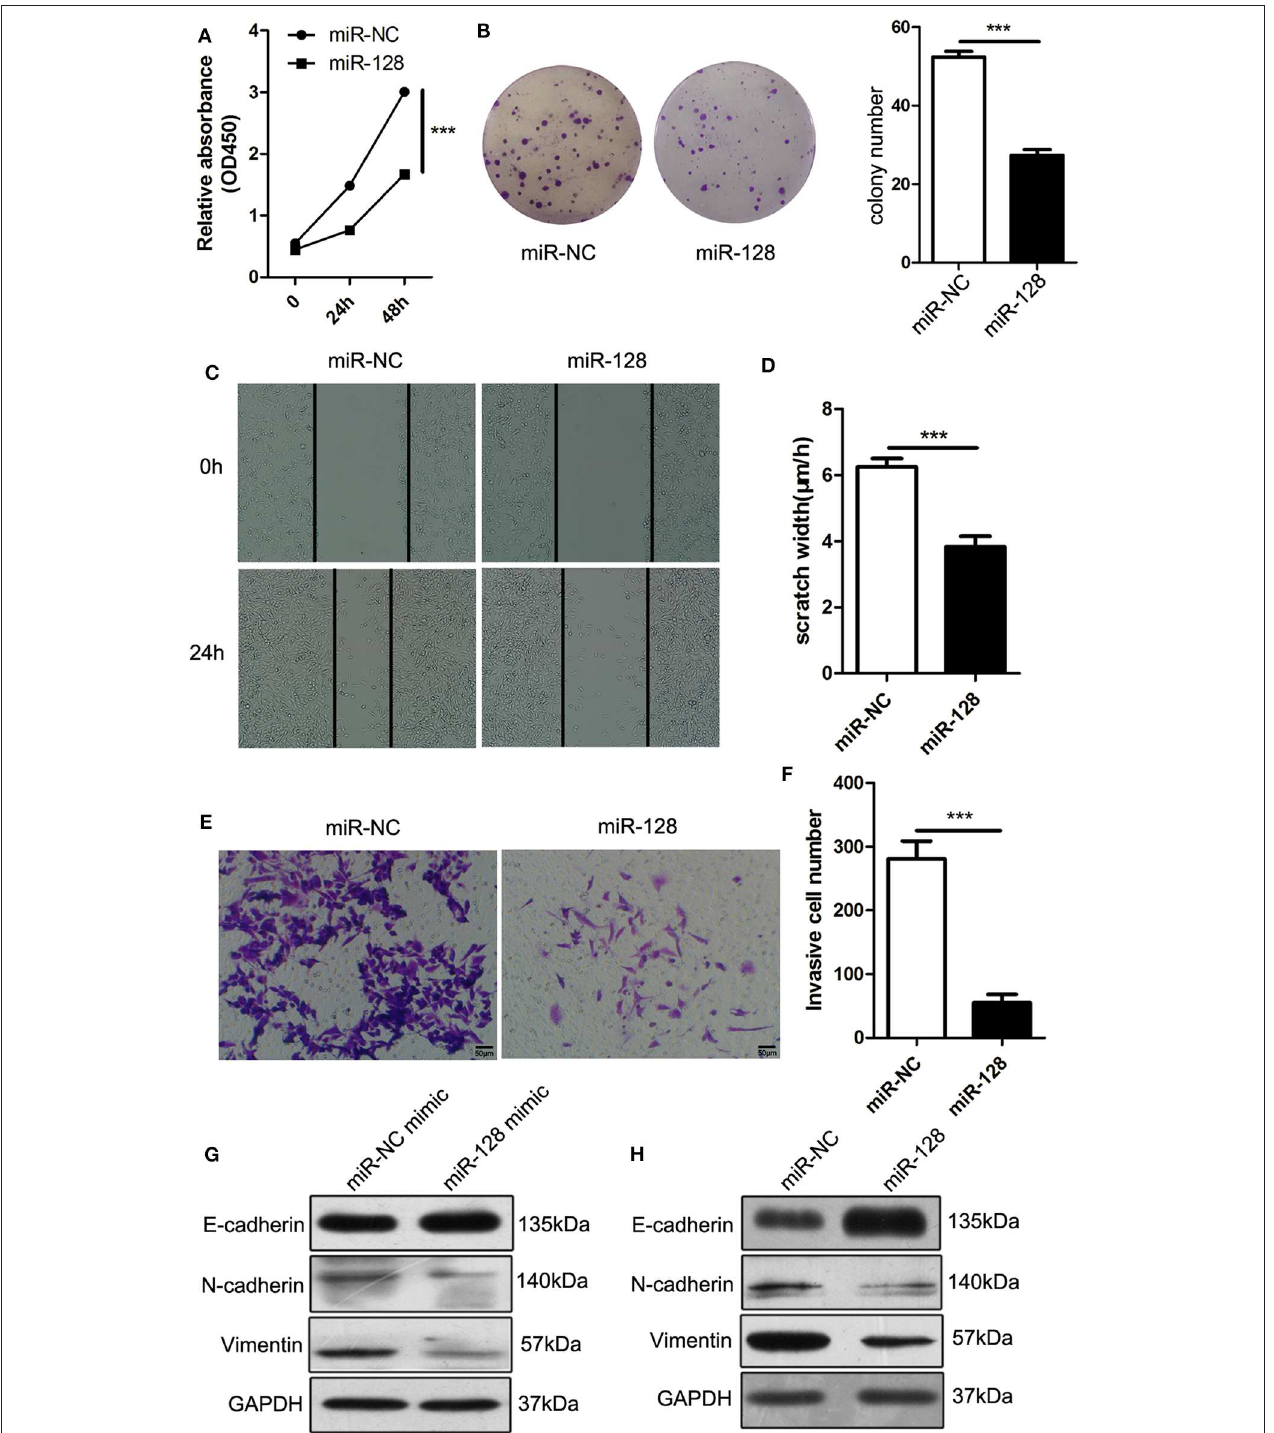
FIGURE 5 | MiR-128 inhibited the cell proliferation, migration, and invasion of PDAC cells. (A) Cell Counting Kit-8 (CCK-8) assay: the proliferation of miR-128 lentivirus-infected cells was lower than that of the control group at 24 and 48 h. (B) Clonogenicity assays: the miR-128 lentivirus-infected cells had a significantly lower survival rate than the control cells. (C,D) Wound healing assay: the migration of miR-128 lentivirus-infected cells was slower than that of the control cells. (E,F) Transwell assay: the percentage of cells that invaded through the Matrigel was lower in miR-128 lentivirus-infected cells than in the control cells. (G,H) The expression of genes associated with epithelial–mesenchymal transition (EMT) after mimic transfection and lentivirus infection. The results represent the mean ± SEM from three independent experiments. Comparisons between groups were determined by Student’s t -test. *** p < 0.001.